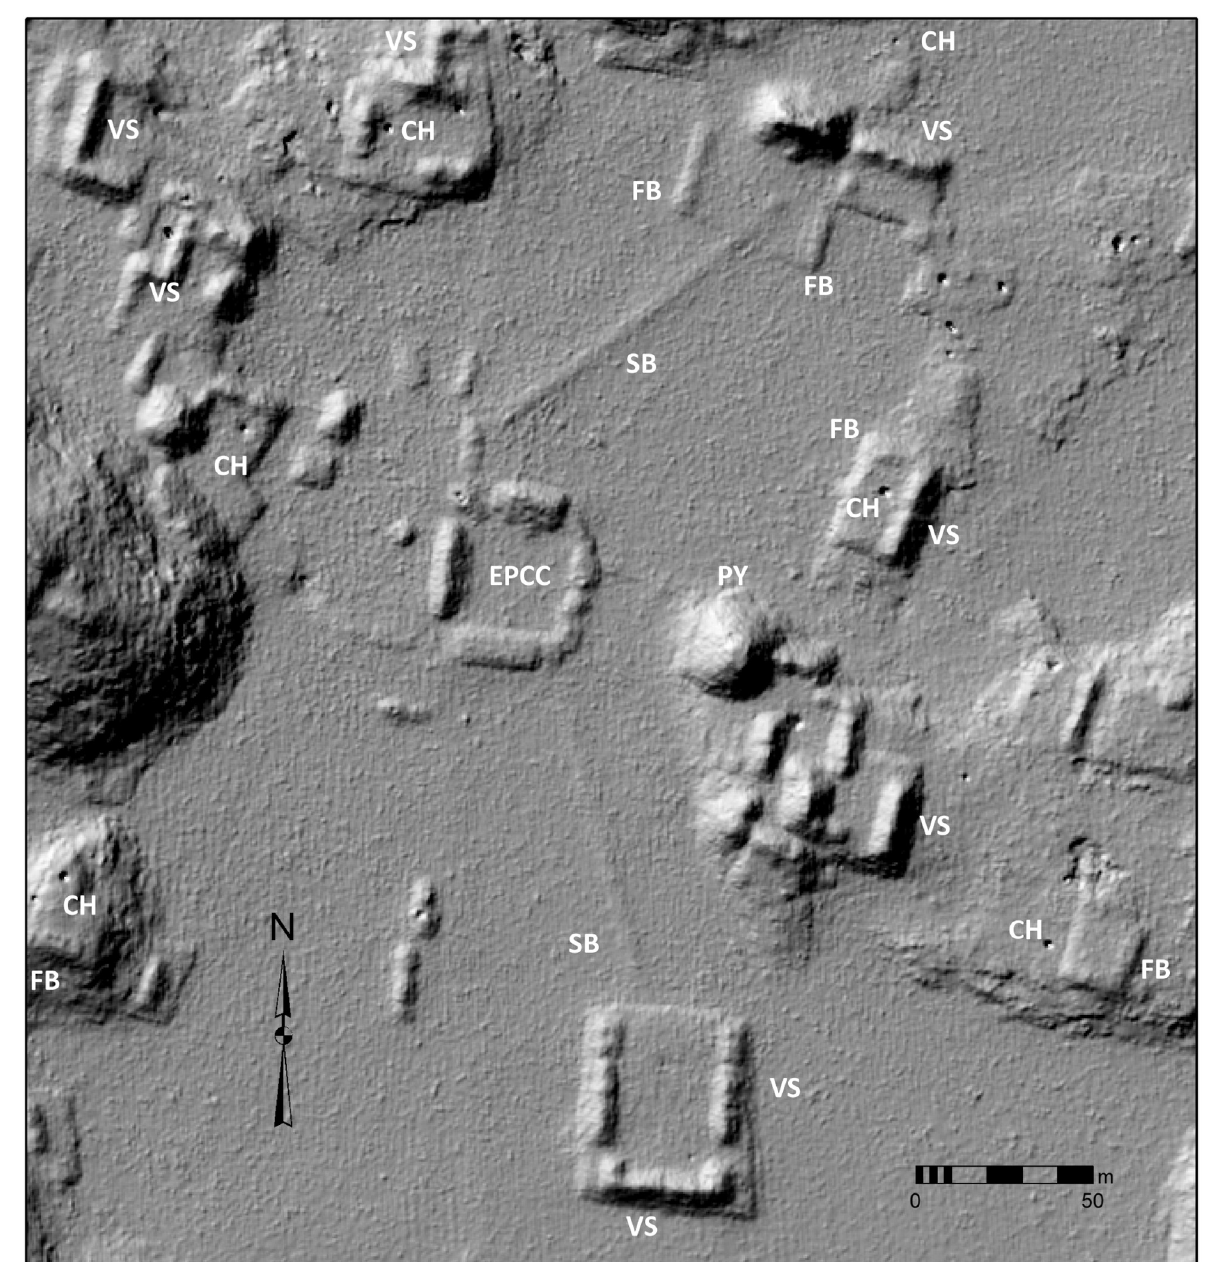
Fig 23. Sacbes (stone causeways) in lidar imagery of Caanil Cah. Note the connection of the earlier EPCC with later complexes with vaulted architecture. SB = sacbe (causeway), EPCC = Early Puuc Civic Complex, PY = pyramid, FB = frame brace, CH = chultun, VS = vaulted building. Not all instances are